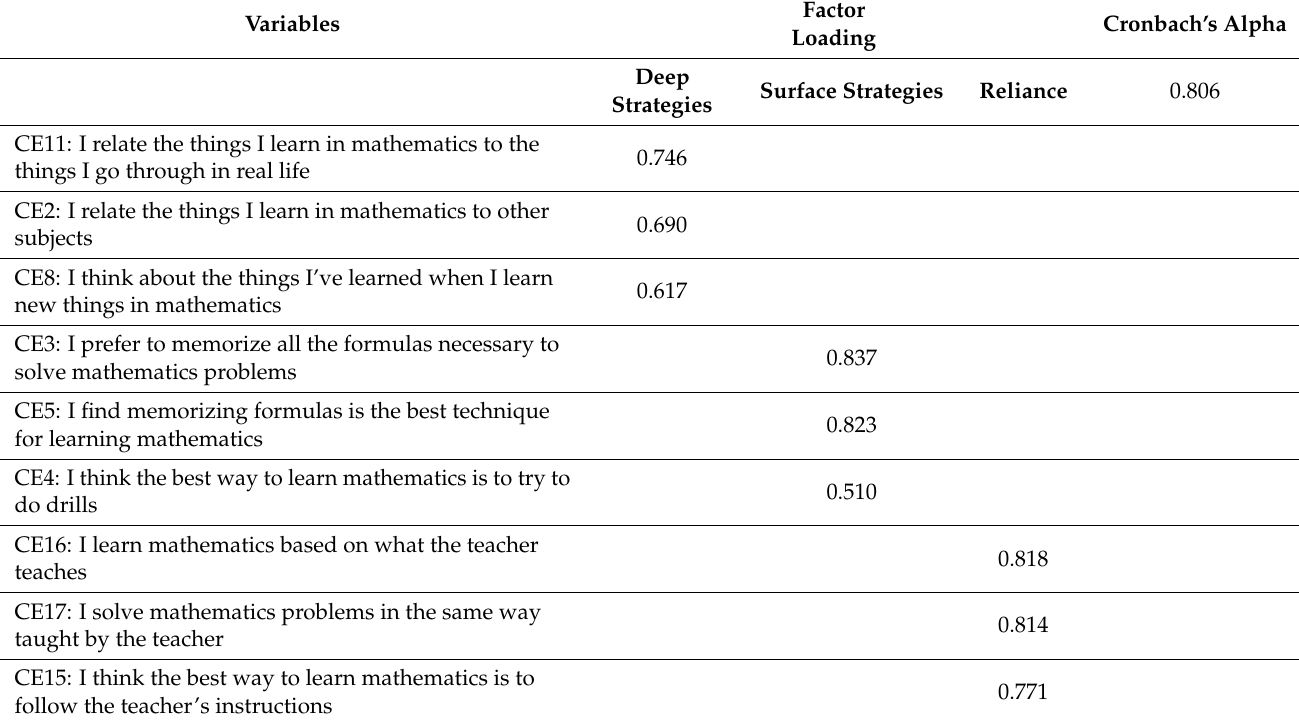
Table 2. Reliability values and factor loading for cognitive